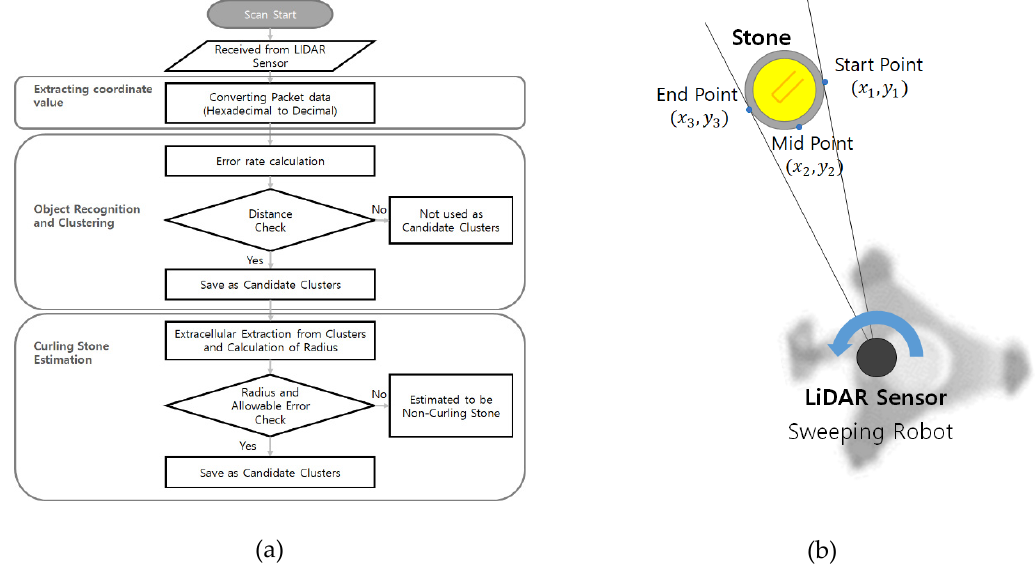
Figure 2. ( a ) Clustering algorithm using light detection and ranging (lidar). ( b ) Three points of cluster.